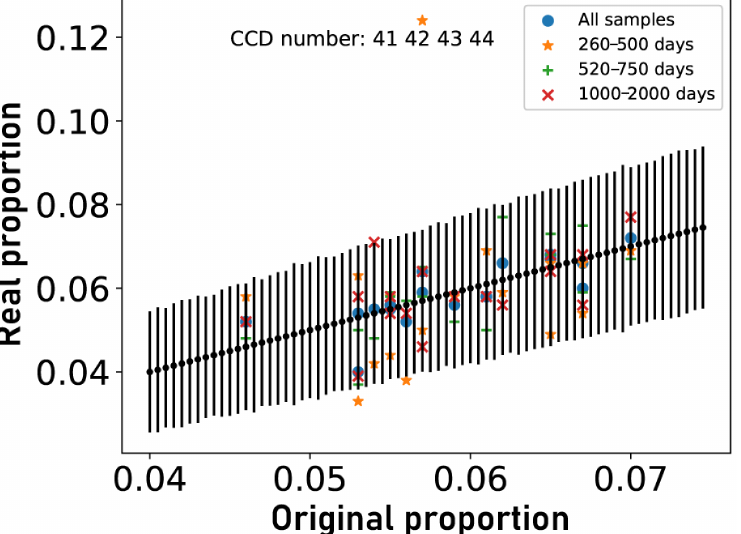
Figure 10. The horizontal coordinate represents the proportion of a CCD sequence to all targets, whereas the vertical coordinate represents the proportion of the same CCD sequence to targets for which a range (shown in the legend) of activity cycles was discovered. The black dots with error bars represent the allowable statistical range (3-sigma). If this range is exceeded, it indicates that the activity cycles within a given range (shown in the legend) are related to the relevant CCD sequence. Three points in the image fall beyond 3-sigma, all of which correspond to cycles of 1 year. One point is obviously abnormal, which corresponds to CCD channels 41 42 43 44 of the cycles between 260 days and 500